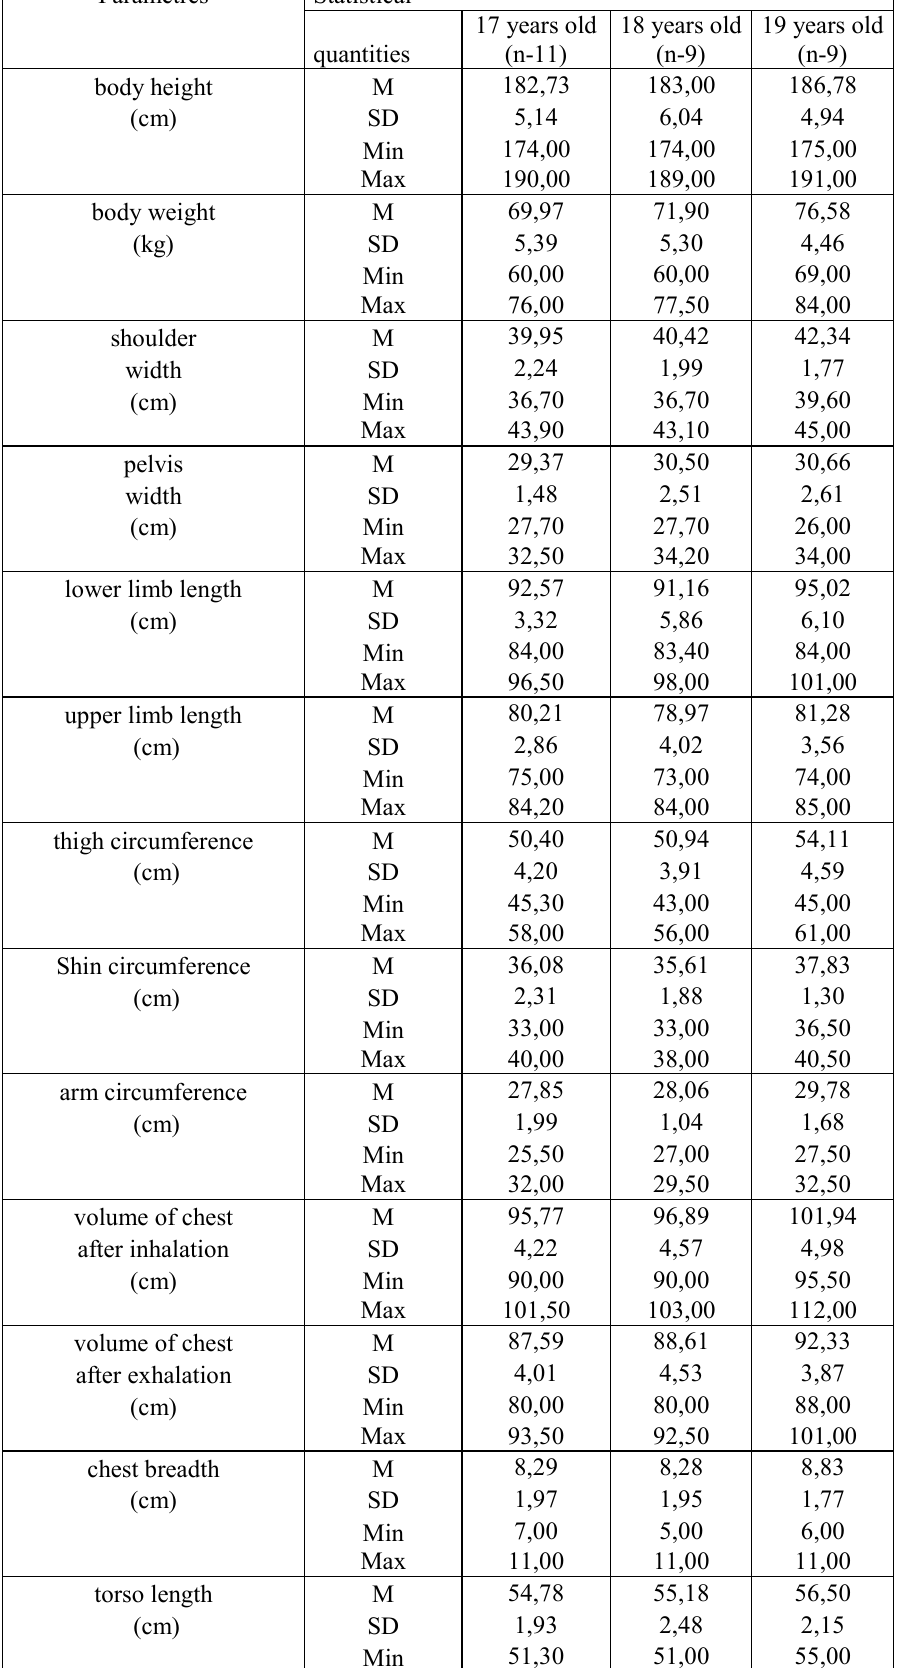
Parameters of the somatic built of 17-19 years’ old vaulters (source, Klimczyk, 2012). Parametres Statistical